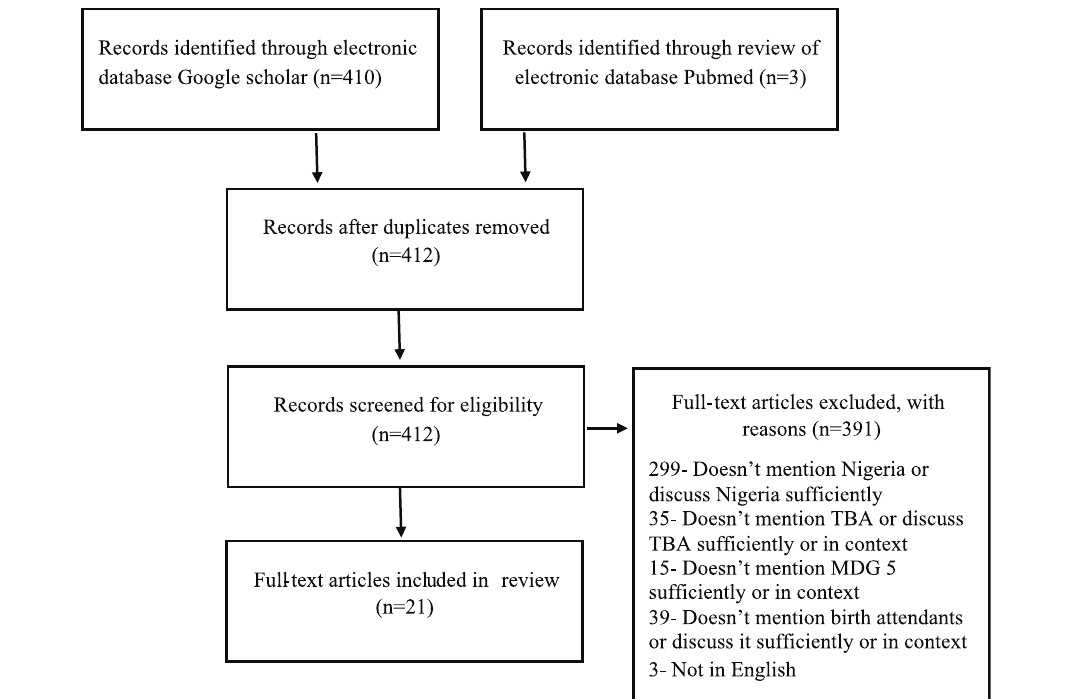
133 © 2017 Global Health and Education Projects, Inc.